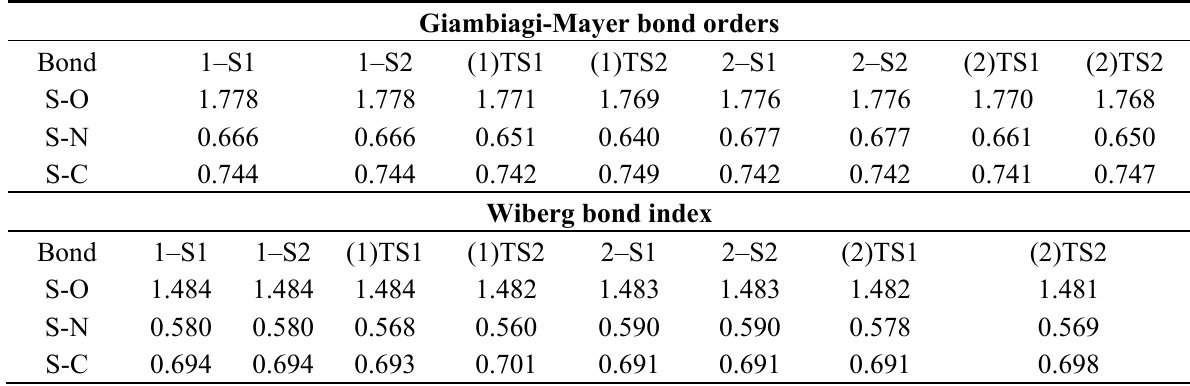
Table 3. Bond orders calculated for the optimised and transition state structures 1 and 2 a .